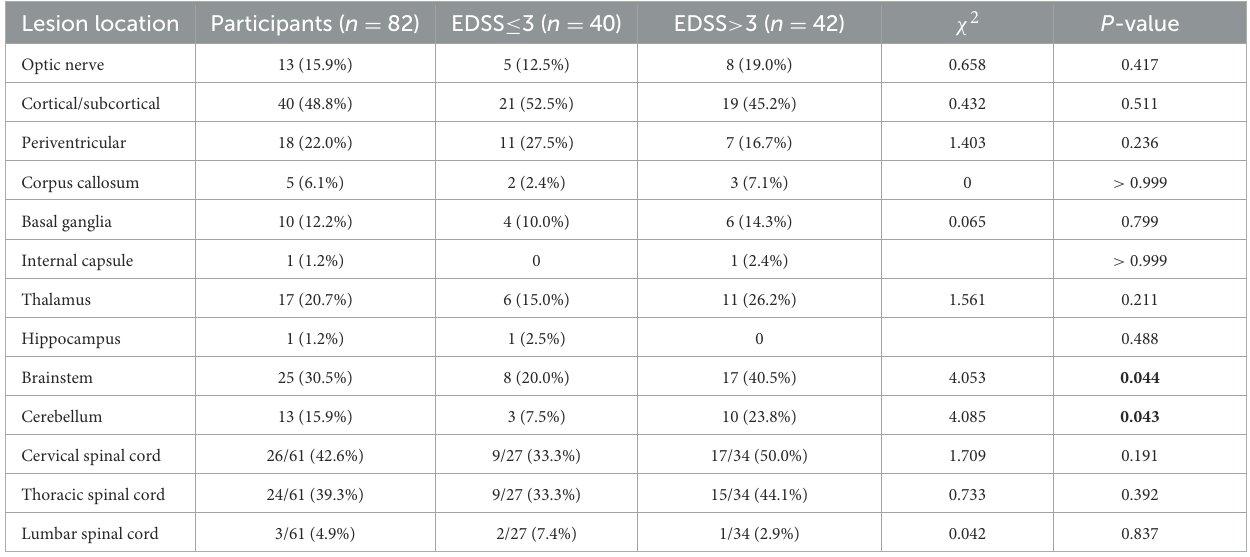
TABLE 4 Localization of brain magnetic resonance imaging lesions in patients according to initial expanded disability status scale (EDSS) scores. Lesion location